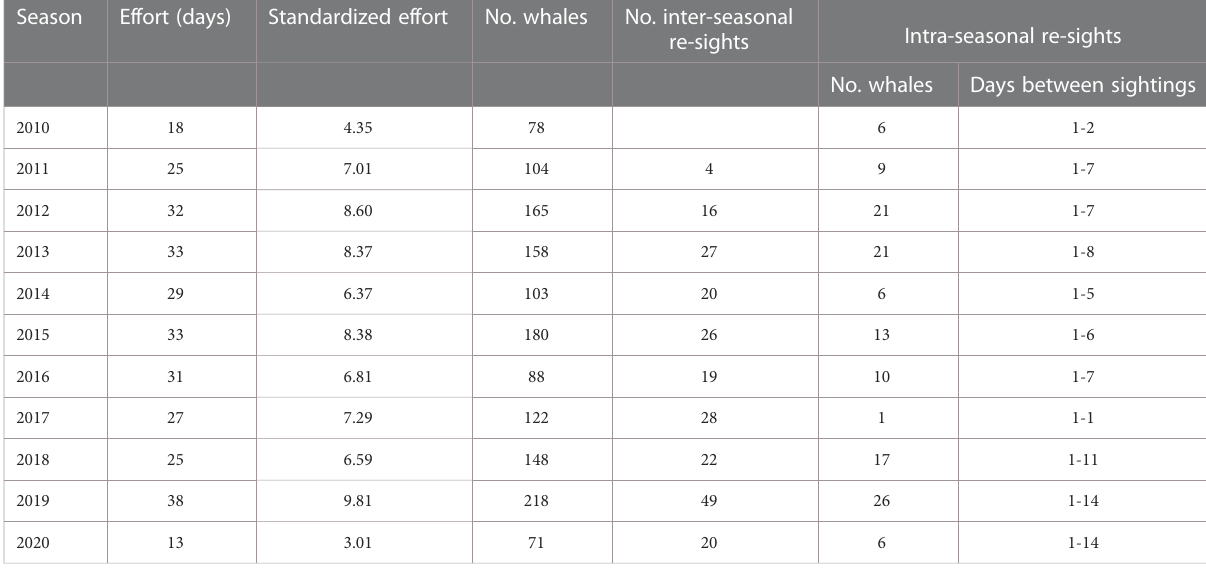
TABLE 1 Survey effort (absolute and standardized), sightings, inter-seasonal re-sights (from all previous years within the period) and intra-seasonal re- sights for each season (December-May, e.g., the 2010 season corresponds to December 2009-May 2010), determined through photo-identi fi cation. Season Effort (days) Standardized